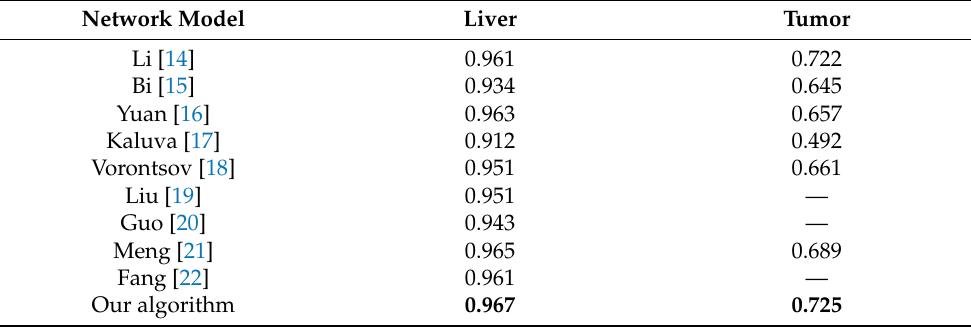
Table 6. Comparison of the Dice coefficients between our algorithm and other algorithms.